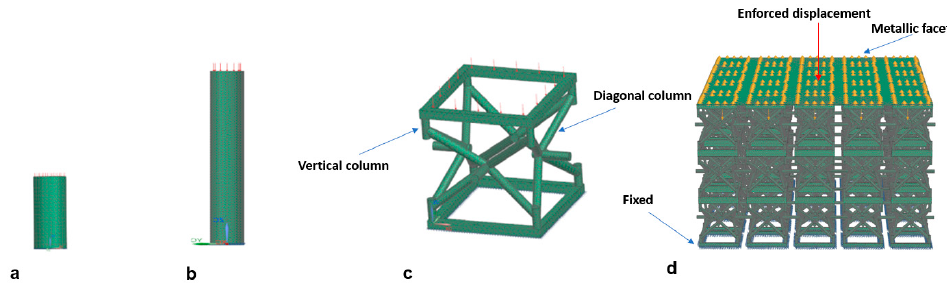
Figure 5. A 3D solid element model of the vertical column ( a ), the diagonal column ( b ), the MFAU unit cell ( c ), and the MFA composite bridge bearing ( d ).